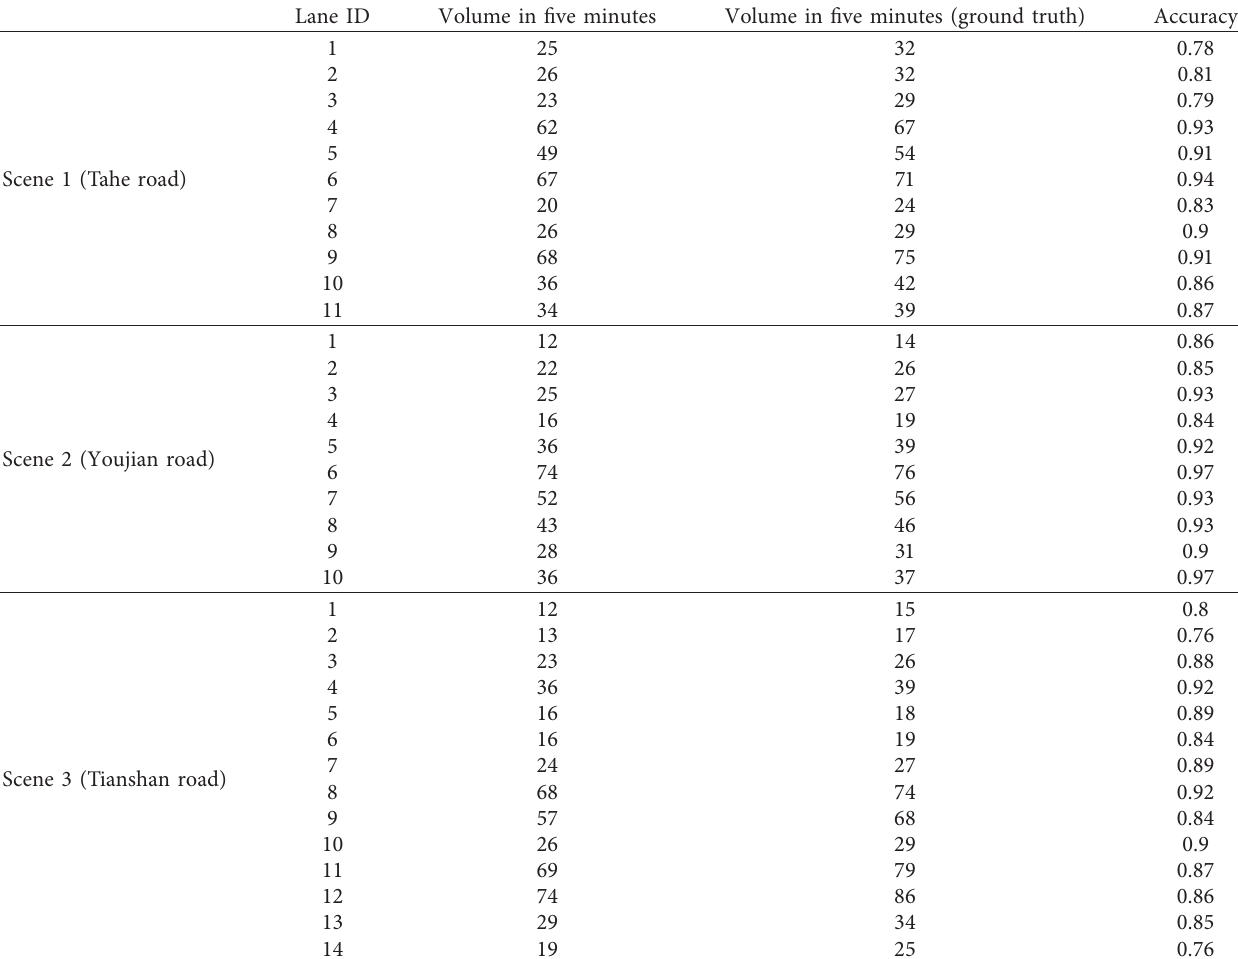
Table 4: Fine-grained lane flow data in